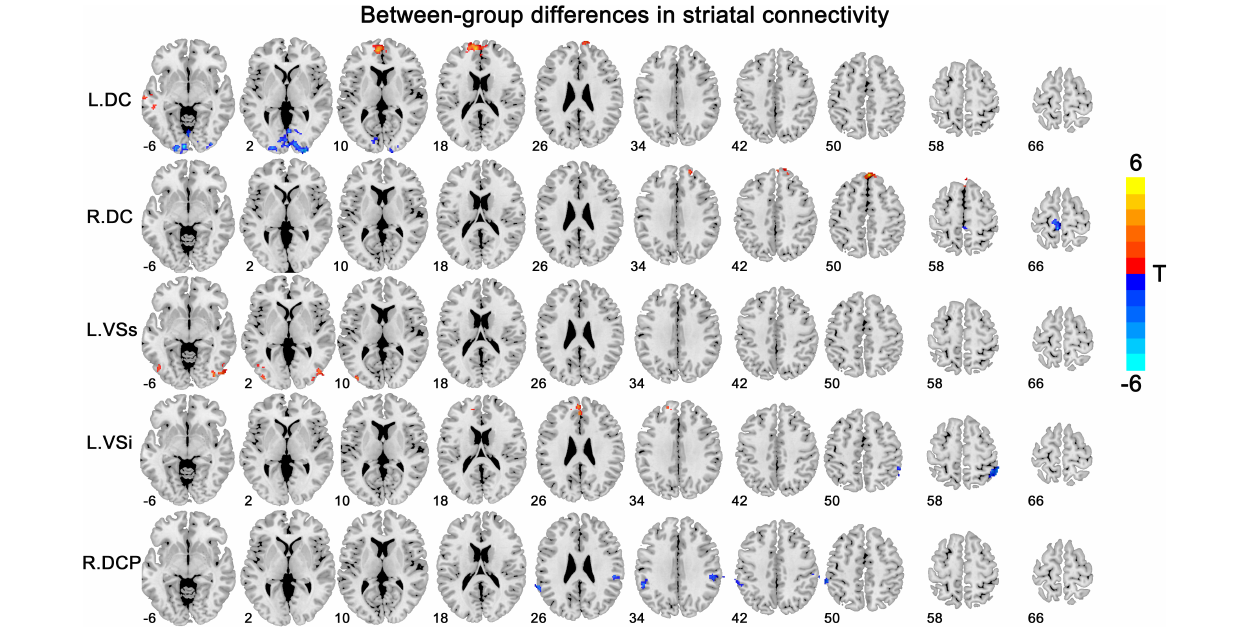
Frontiers in Neuroscience |